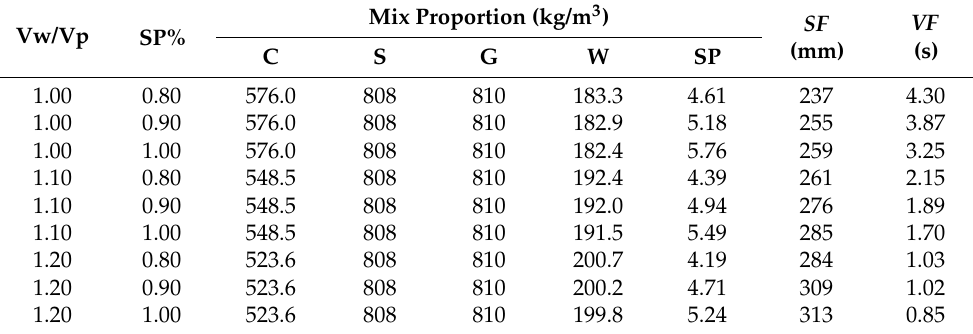
Table 5. Mix proportions and test results of SCC in series